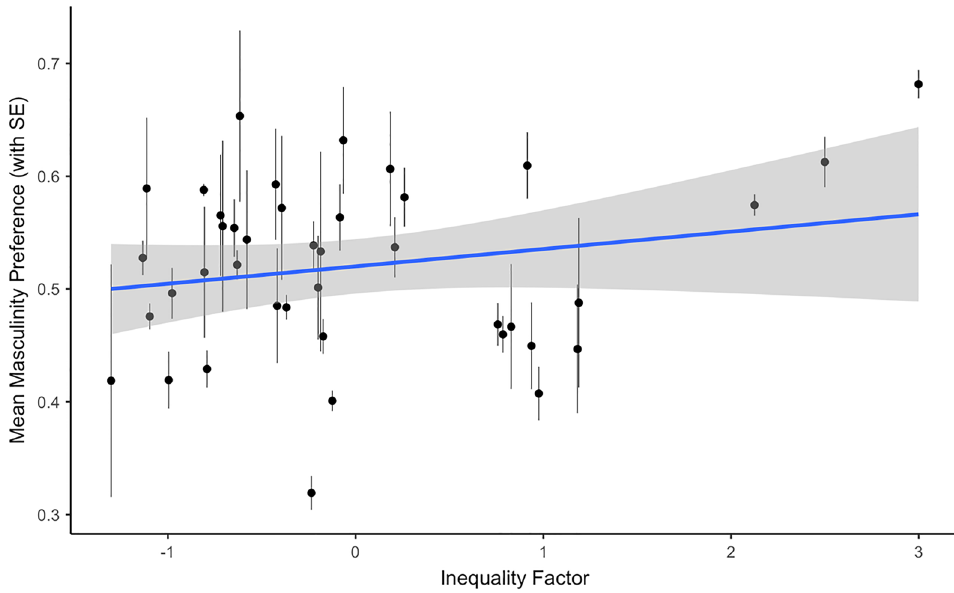
Figure 3. The significant association between scores on the inequality factor and women’s preferences for male facial masculinity.